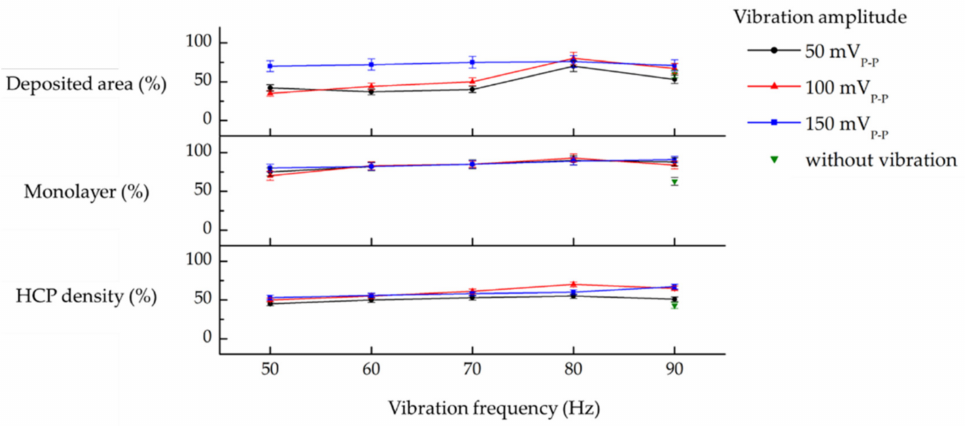
Figure 9. Percentages of deposited area, monolayer, and HCP density of self-assembled PS films with vibration frequency and